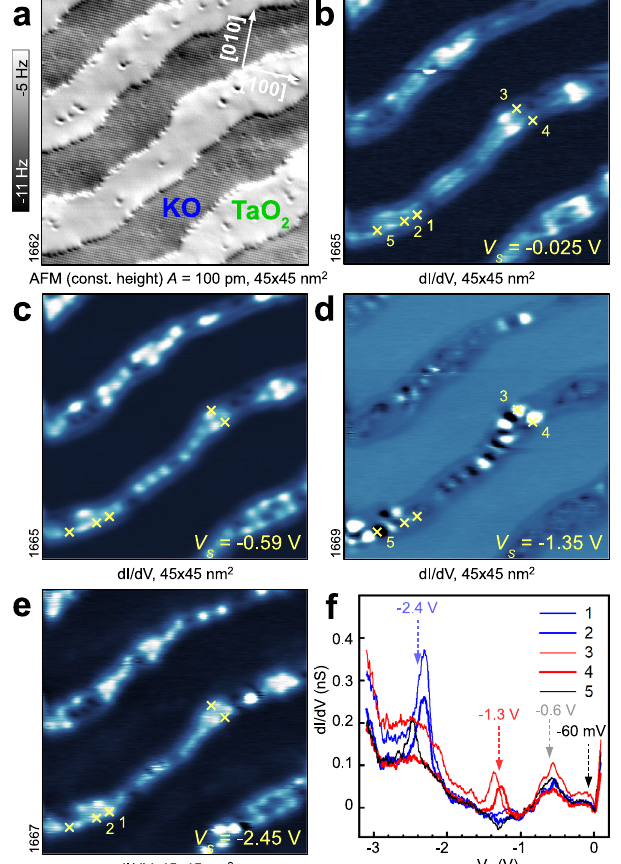
Fig.1|Spatiallyresolvedelectronicstructureofbulk-terminatedKTaO 3 (001). Alldataacquiredinconstant-heightmodeat T =4.8K. a ncAFMimageshowing terraceswithalternatingKOandTaO 2 terminations. b – e Conductancemapsofthe sameareaatdifferentsamplevoltages V S . f STSspectrameasuredatpositions markedinpanels( b – e